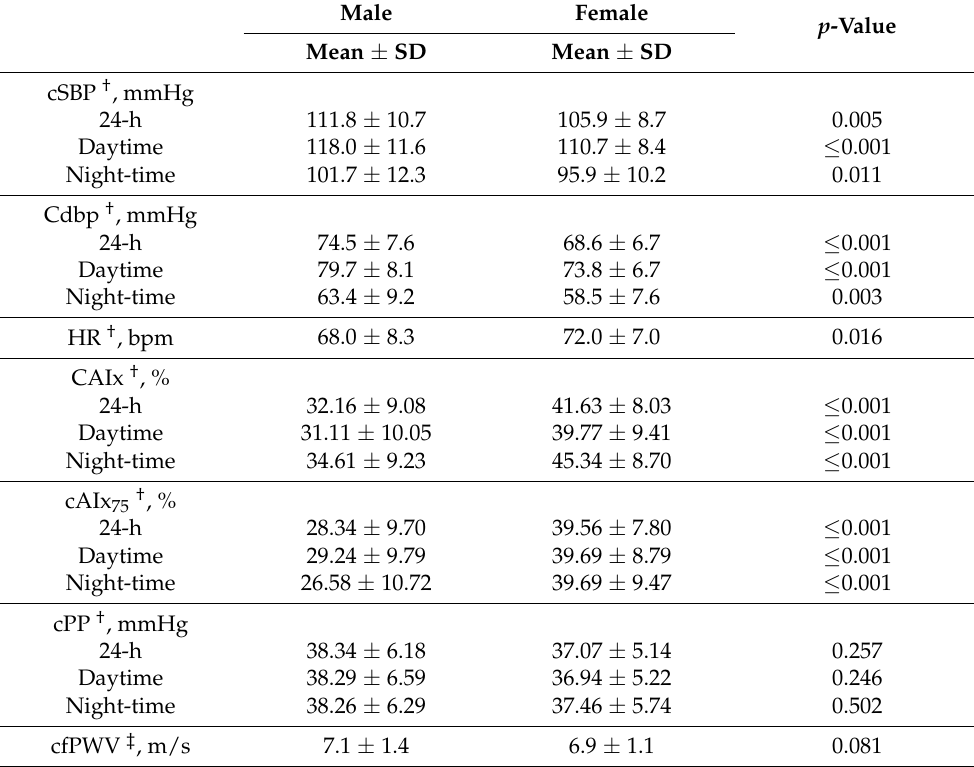
Table 2. Clinical profile of the study population.